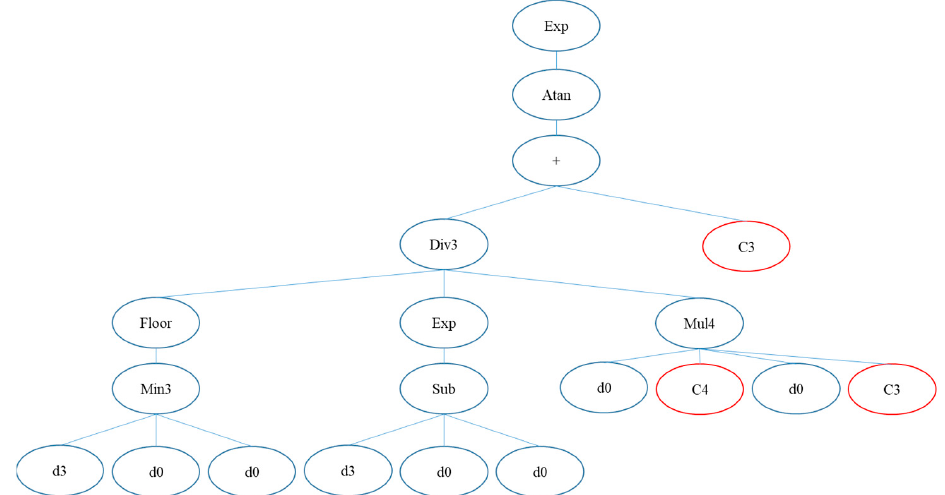
Figure A1. Sub-ET1 of GEP bathymetry retrieval model.